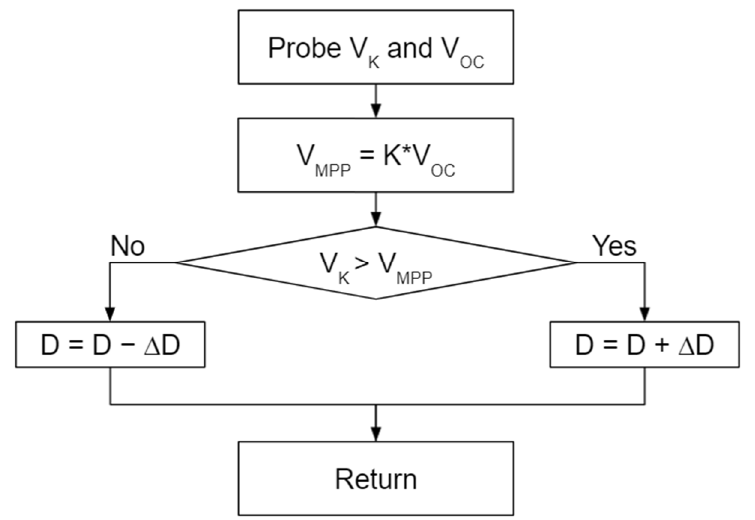
Figure 3. Flowchart of the FOCV algorithm.